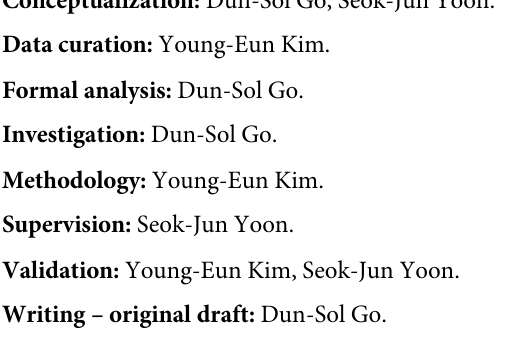
S1 Table. Weights for domains and indicators by analytic hierarchical